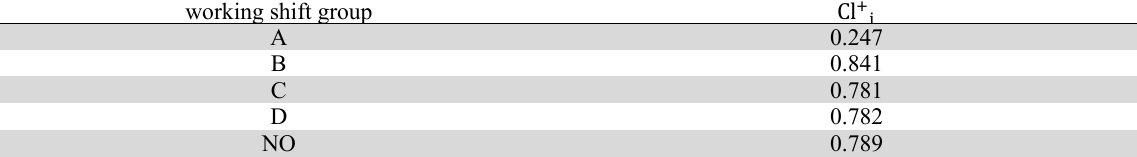
Relative similarity to ideal amounts of the compared alternatives working shift group Cl (cid:2878)